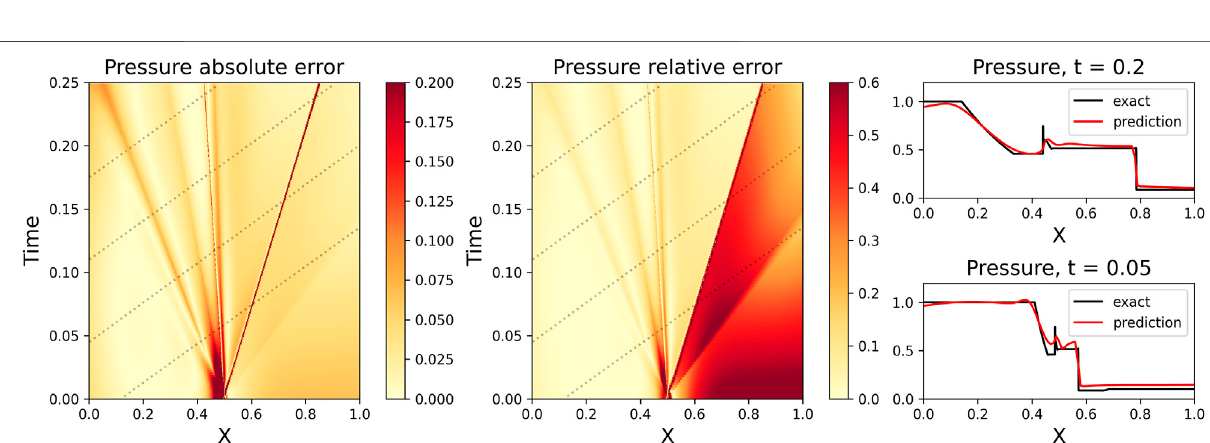
Frontiers in Astronomy and Space Sciences |